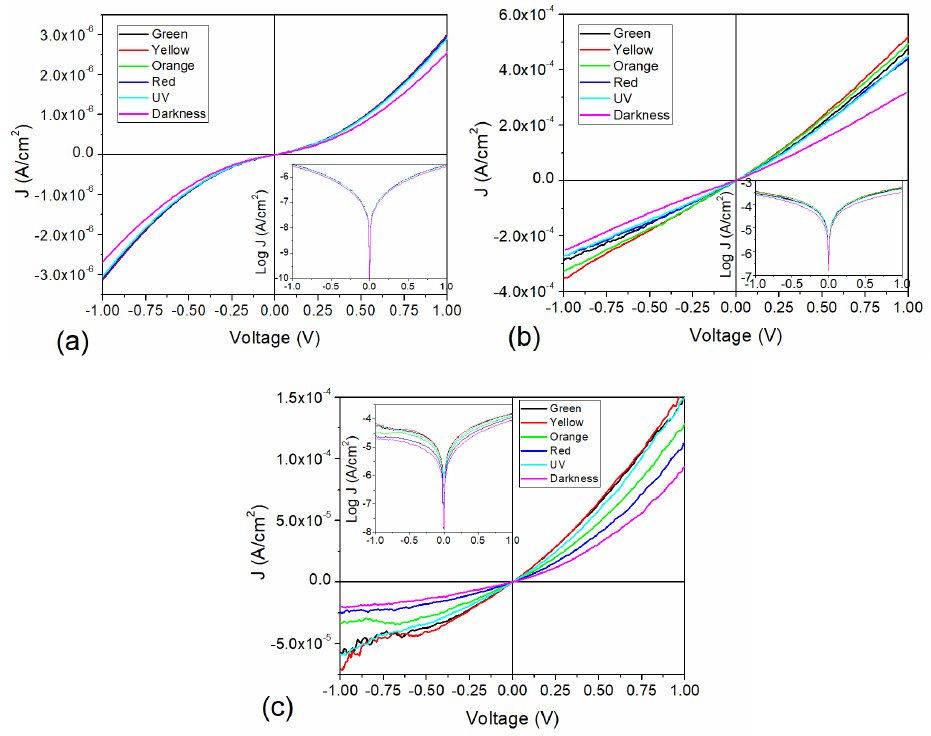
Figure 8. J-V and semi-Log J-V curves for doped ( a ) CoPc, ( b ) ZnPc and ( c ) CuPc for different incident light colors.